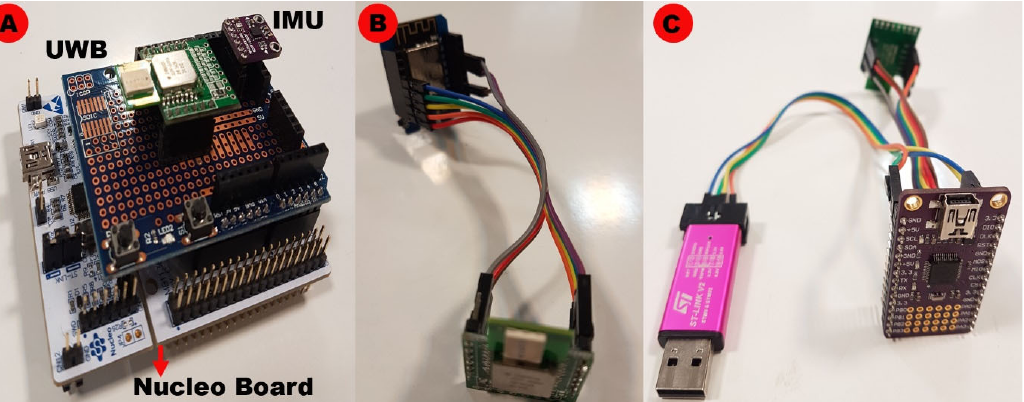
Figure 7. ( A ) Prototype used for user position estimation, ( B ) Data coordinator, ( C ) Anchor. The coordinator encapsulates and converges all the transmitted distances in the local fog for the final position estimation of the user.